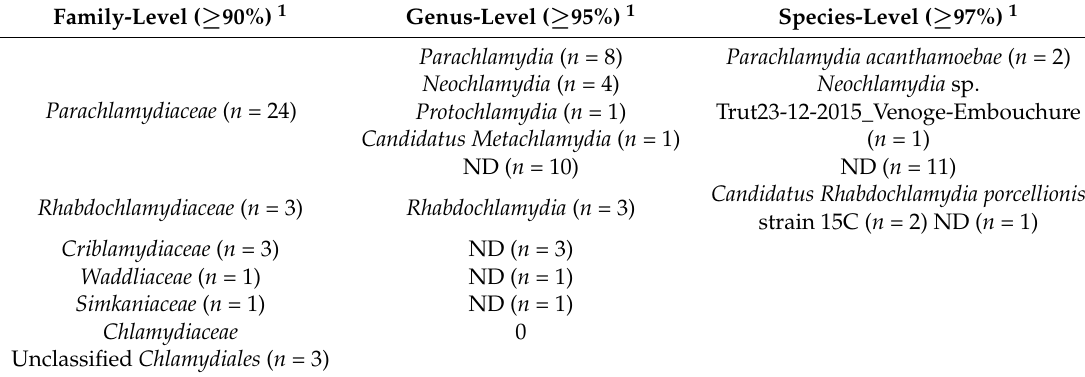
Figure 1. Chlamydiales families in the sequenced pan- Chlamydiales PCR-positive tick and skin samples. CLOs belonging to the Parachlamydiaceae family were the most common family-level lineage in ticks. Unclassified Chlamydiales were prevalent in skin biopsies. Table 2. Sequencing results and classification of the 16S rRNA gene fragment of pan- Chlamydiales PCR-positive tick samples ( n = 35).